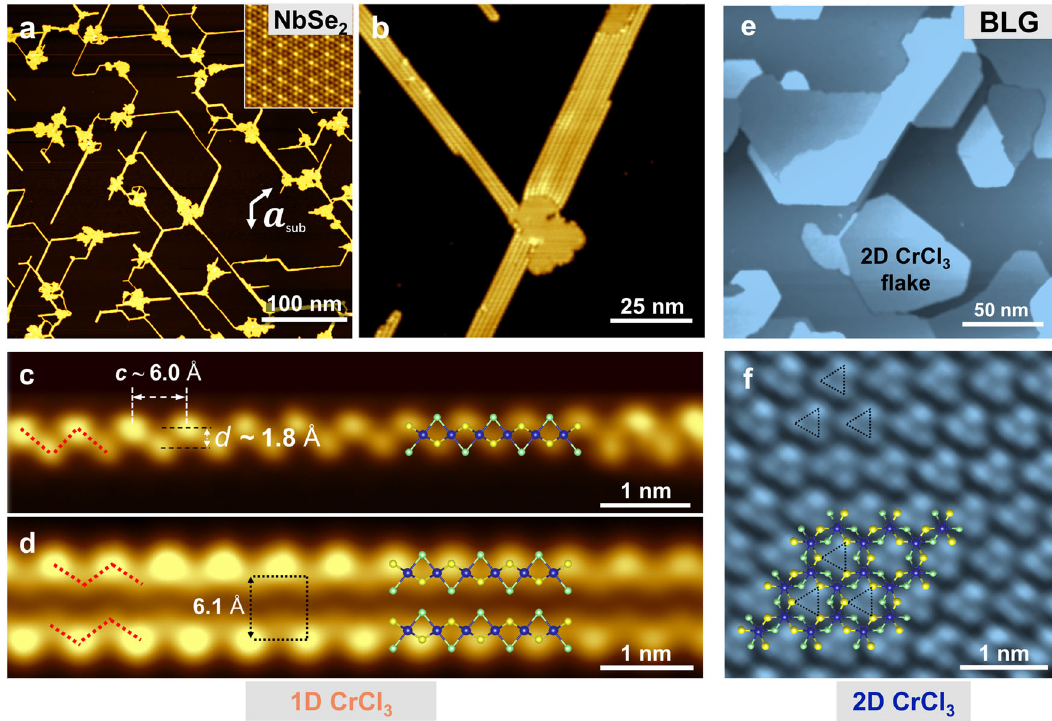
Fig. 1 | STM images of 1D CrCl3 wires on NbSe2 and 2D CrCl3 fl akes on BLG. a STMimageofCrCl 3 grownonabulkNbSe 2 surface(1.1V, 10pA).Theinsetshows the atomically resolved STM image taken on the nearby NbSe 2 . The prime vector a sub oftheNbSe 2 latticeismarkedasshown. b Close-upimage(1.1V,10pA)showing that the as-grown 1D structures consisted of integer numbers of atomic